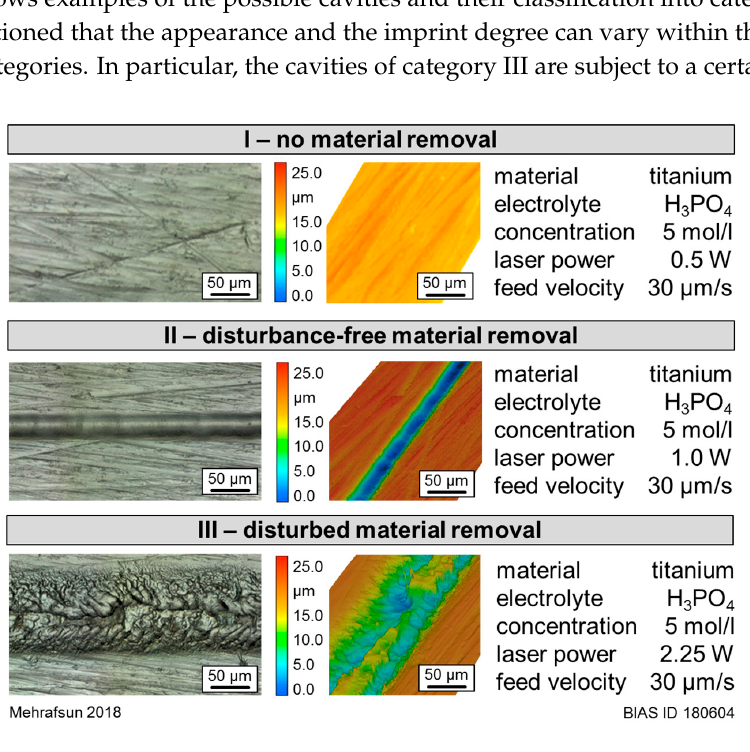
Figure 3. Examples of the different resulting cavities and their related categories.